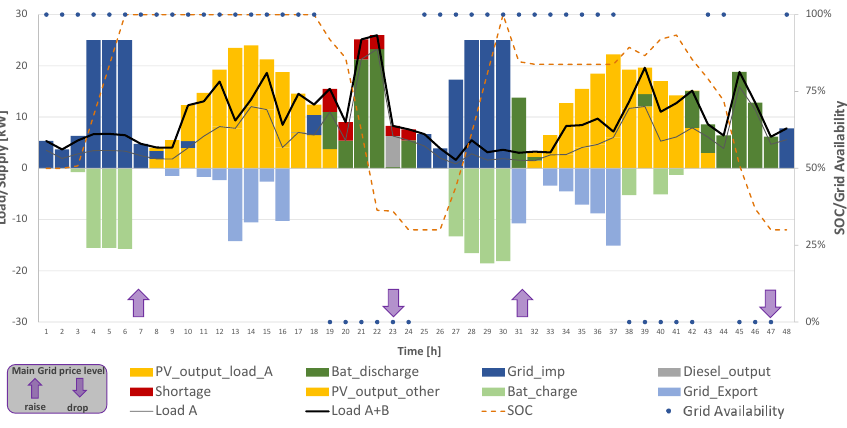
Figure 8. UMG optimal dispatch for dry season and unreliable grid.